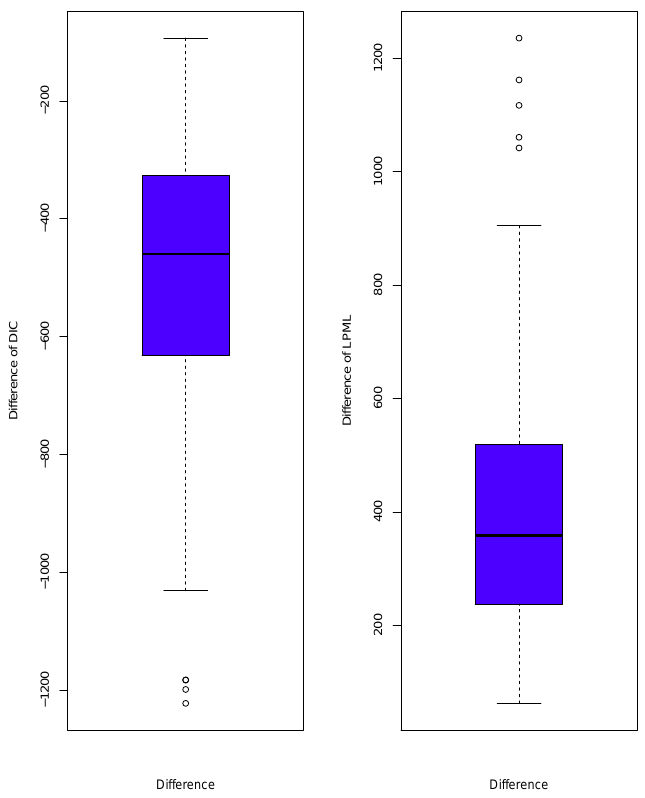
Figure 4. DIC and LPML difference (( left ) DIC, ( right )